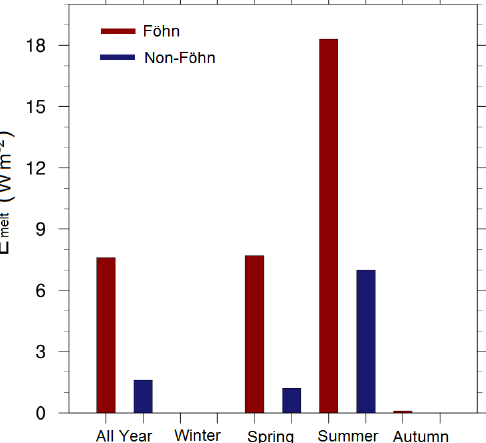
Figure 7. The observationally derived melt energy E melt values from AWS2 during föhn and non-föhn conditions, separated by sea-